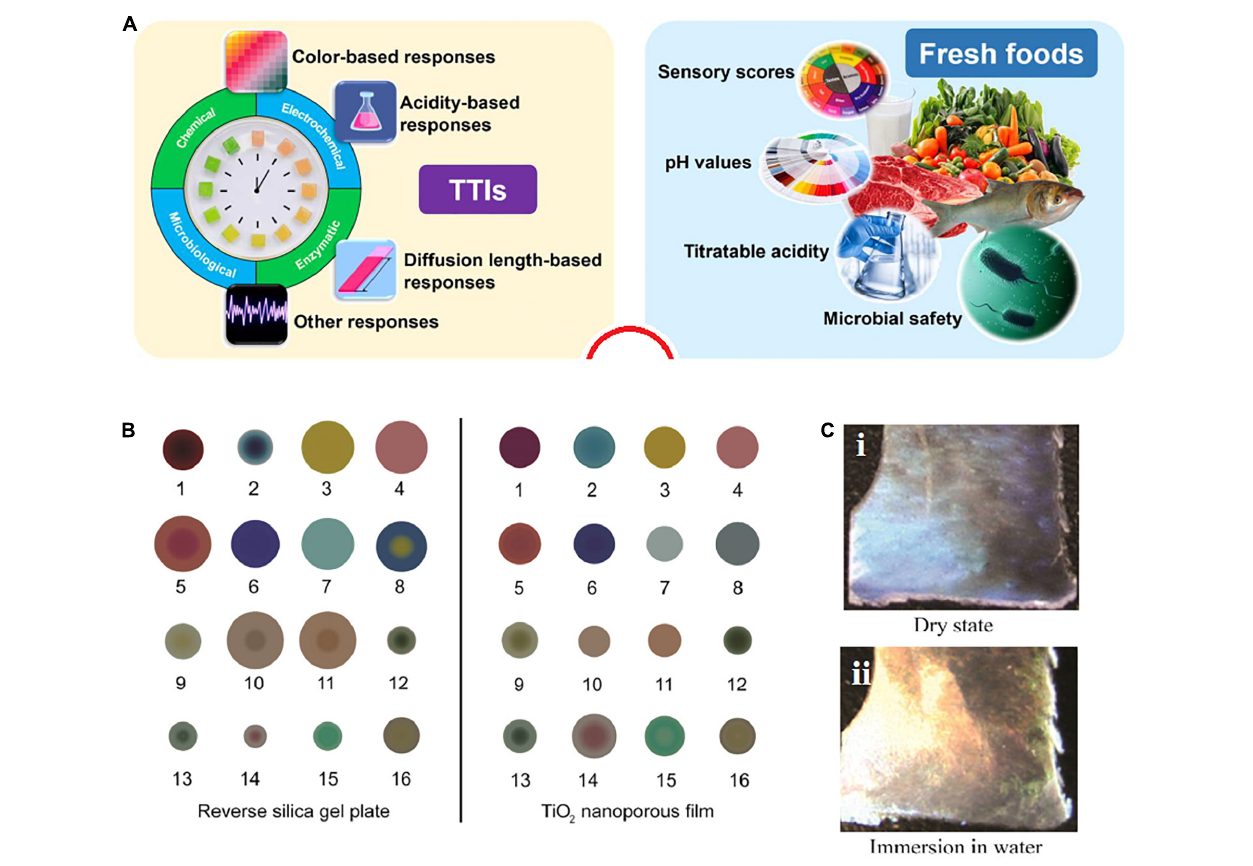
FIGURE 5 | (A) Employed parameters for designing TTIs (left) and indexes for informing about the conditions (right) [reproduced with permission from Gao et al. (2020)]. (B) A colorimetric sensor based on the TiO 2 (right) and reverse gel silica plate films (left) [reproduced with permission from Xiao-wei et al. (2016)]. (C) Color changes of CNC film: (i) dry film, (ii) after immersing in water [reproduced with permission from El Asbahani et al.